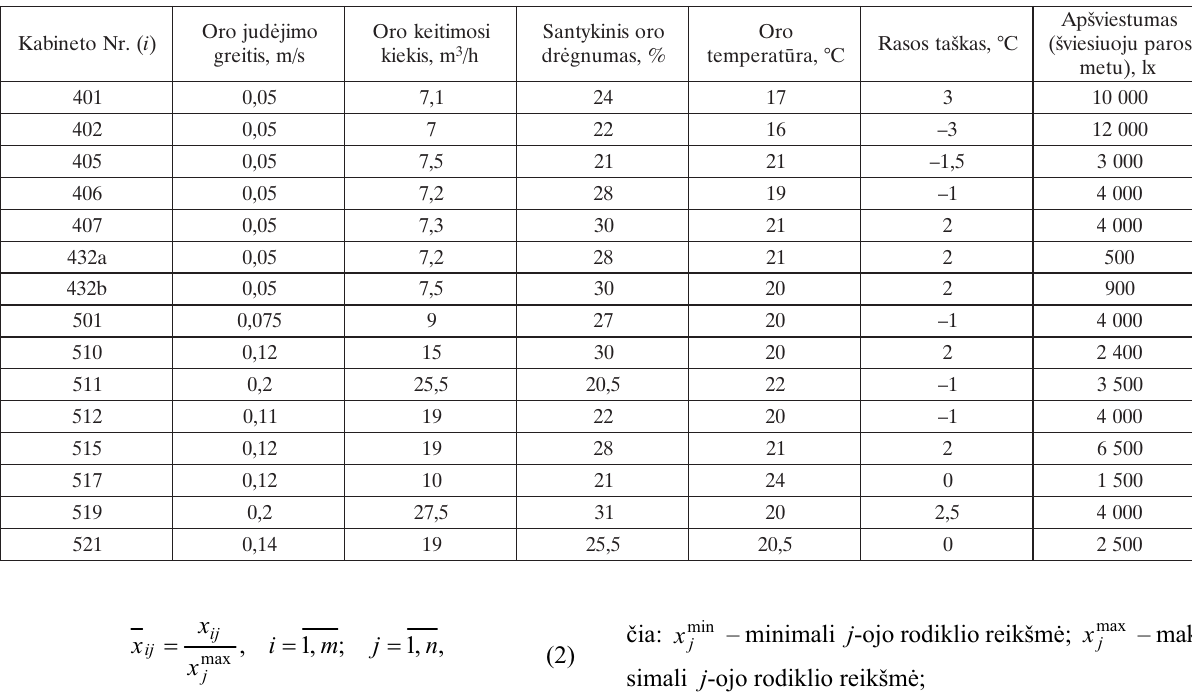
Table 2. Measurement average